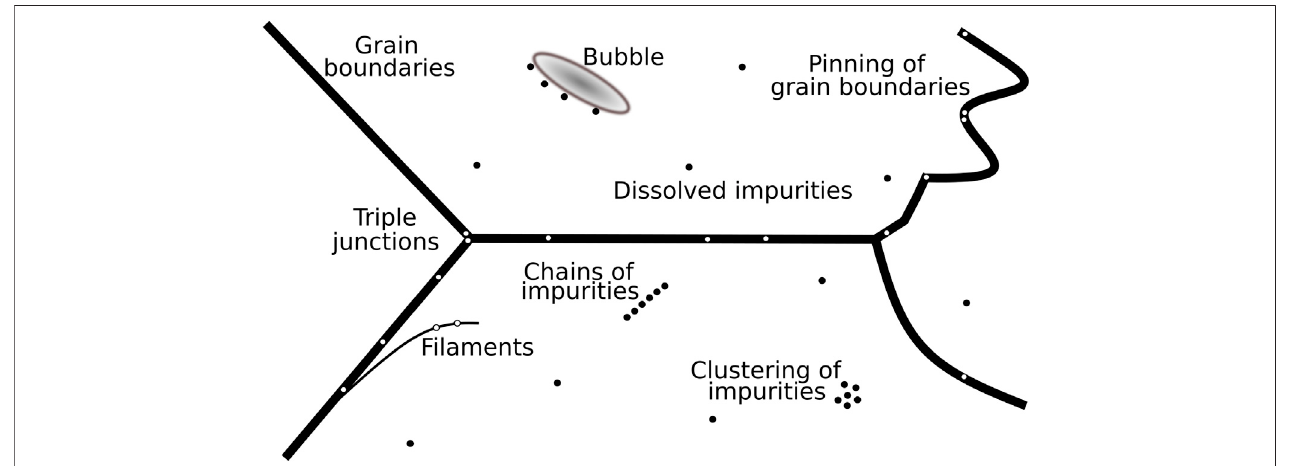
FIGURE7| Schematicpossiblemicrostructurallocationsofimpuritiesinpolarice.Insolubleimpuritiesaredisplayedasblackandwhitedotsinthegraininteriorand on grain boundaries, respectively. Modi fi ed from Figure 7 from Barnes et al. (2003b).